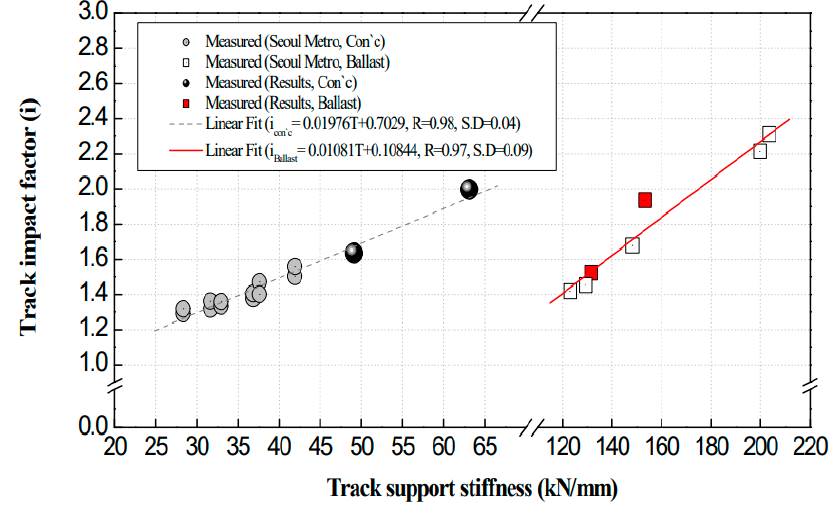
Figure 4. Correlation between track impact factor and track support stiffness [3].